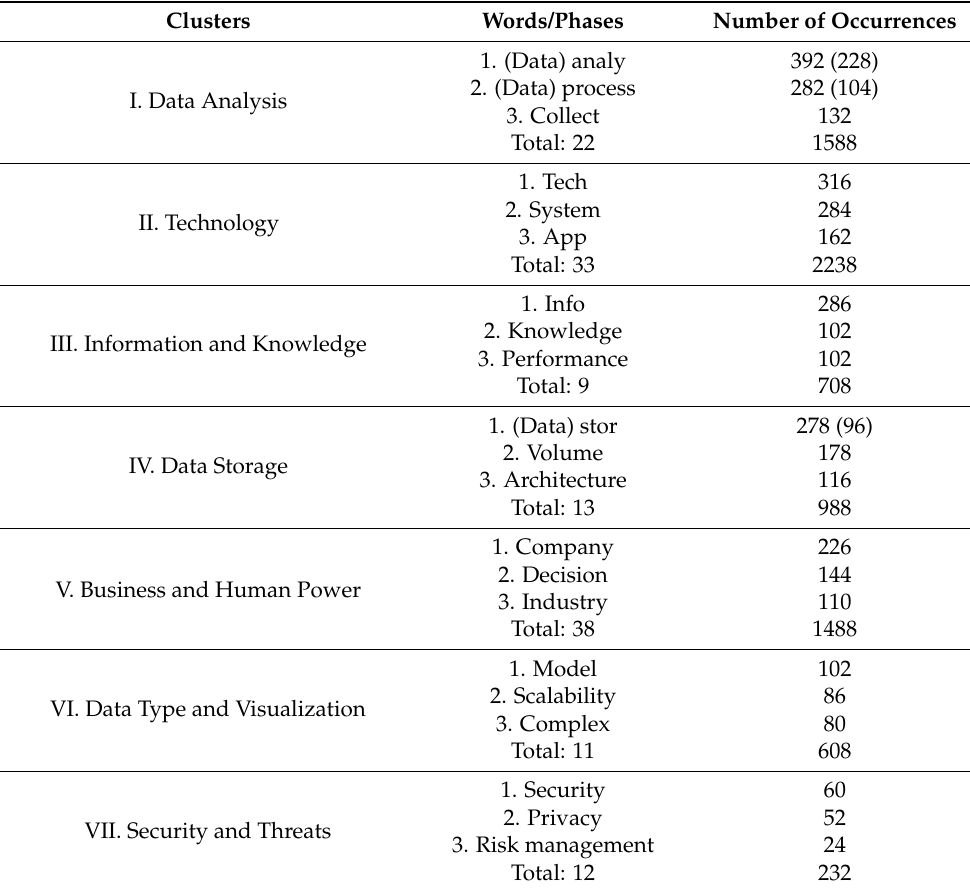
Table 4. Seven clusters of big-data management and three most significant words or phrases.